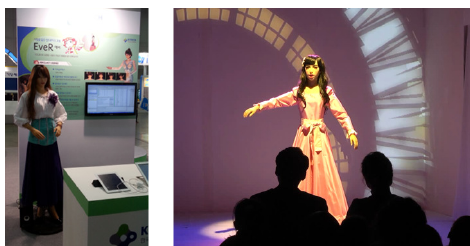
Figure 1. Android, EveR, in various exhibitions and